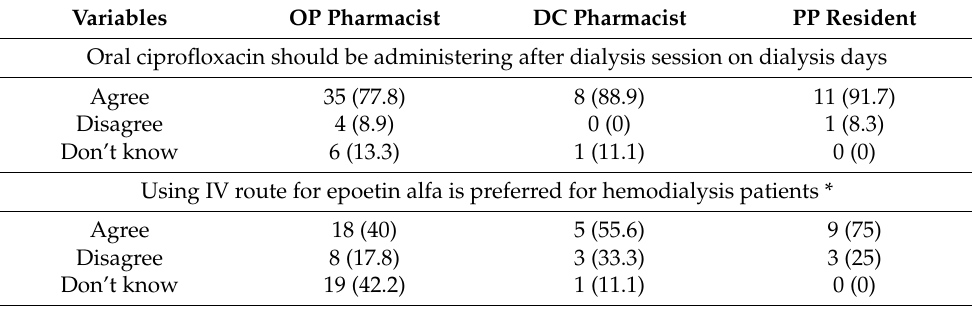
Table 4. Knowledge of the pharmacists towards prescribed medications for